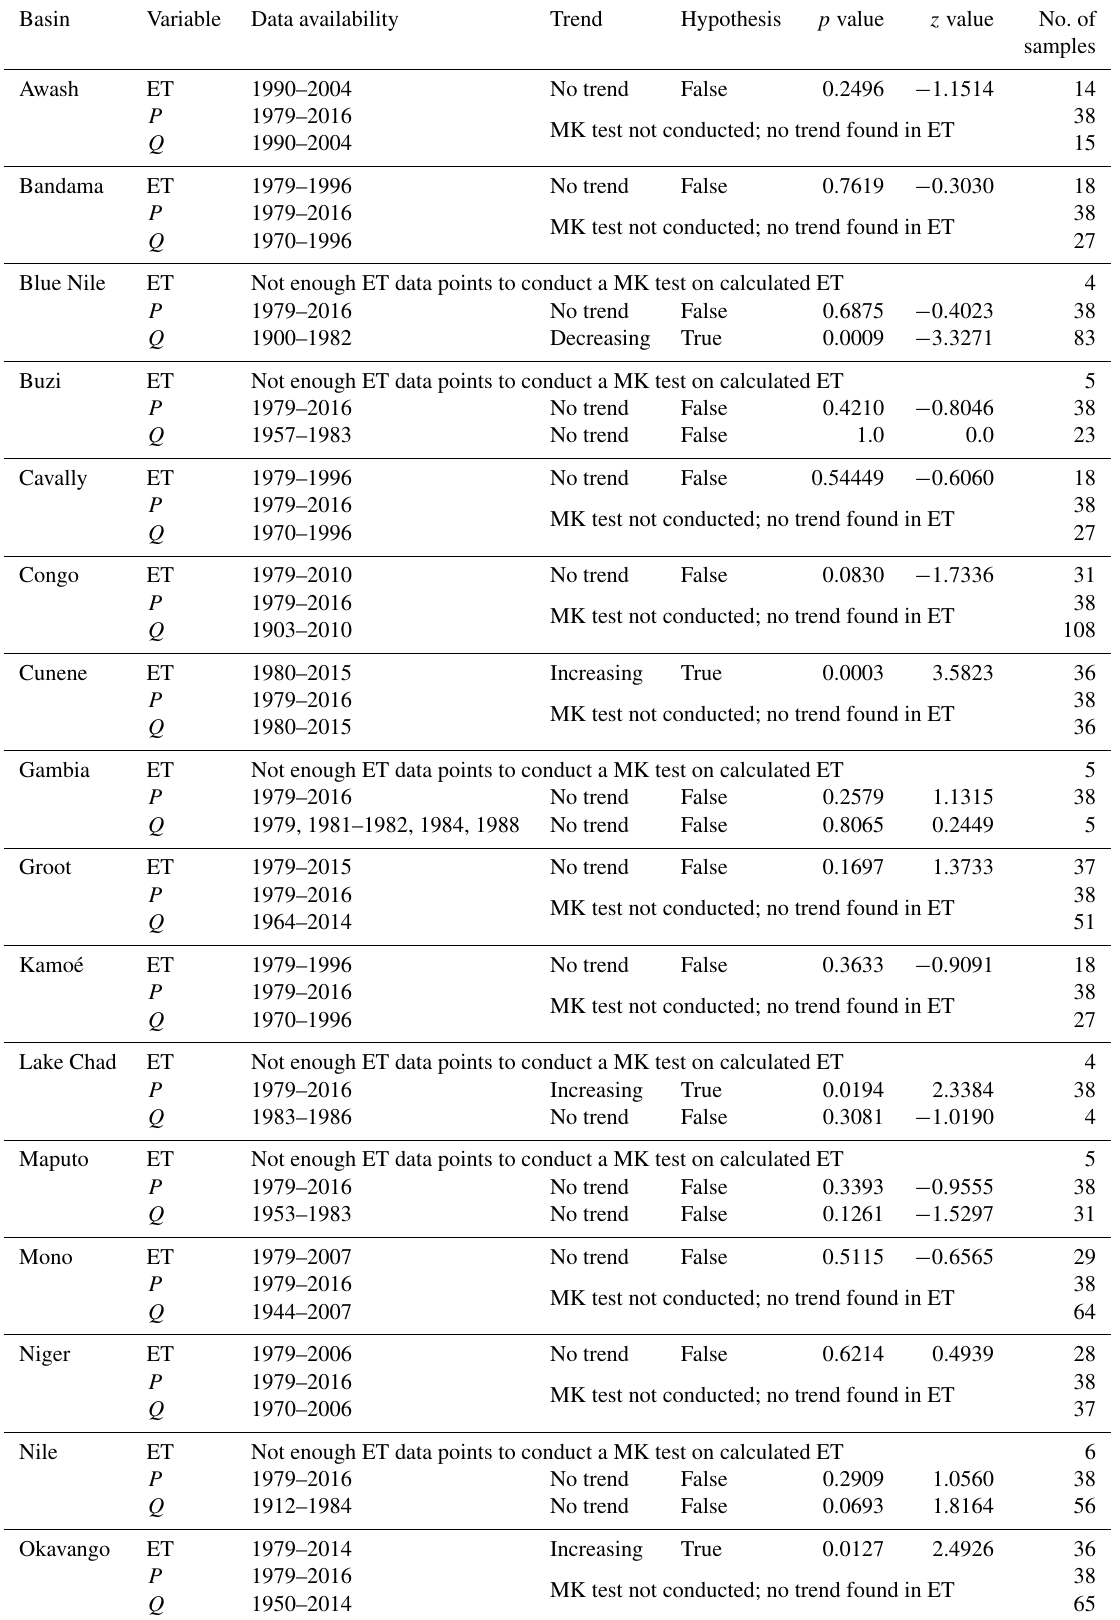
Table 6. Results and details of the MK test for each basin analysed.